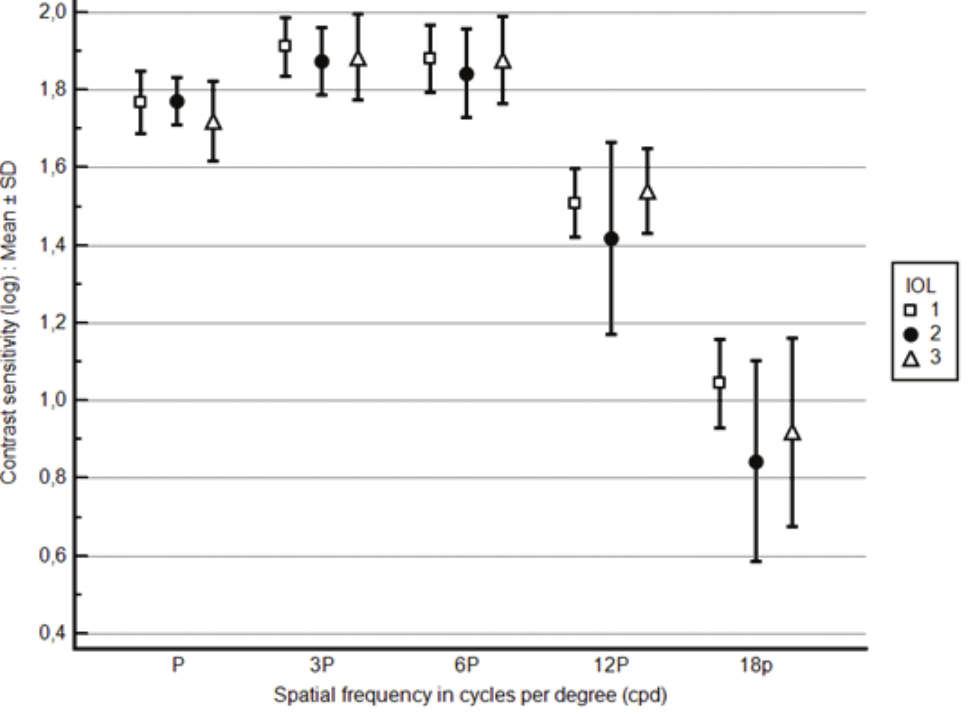
Figure 1. Postoperative contrast sensitivity (log) under photopic conditions (85 cd/m2) in various spatial frequencies for the IOLs included in the study [IOL1 = Bioline Yellow Accurate (i-medical, Germany), IOL2 = BioAcryl 60125 (Biotech, France), IOL3 = H65C/N (PhysIOL,